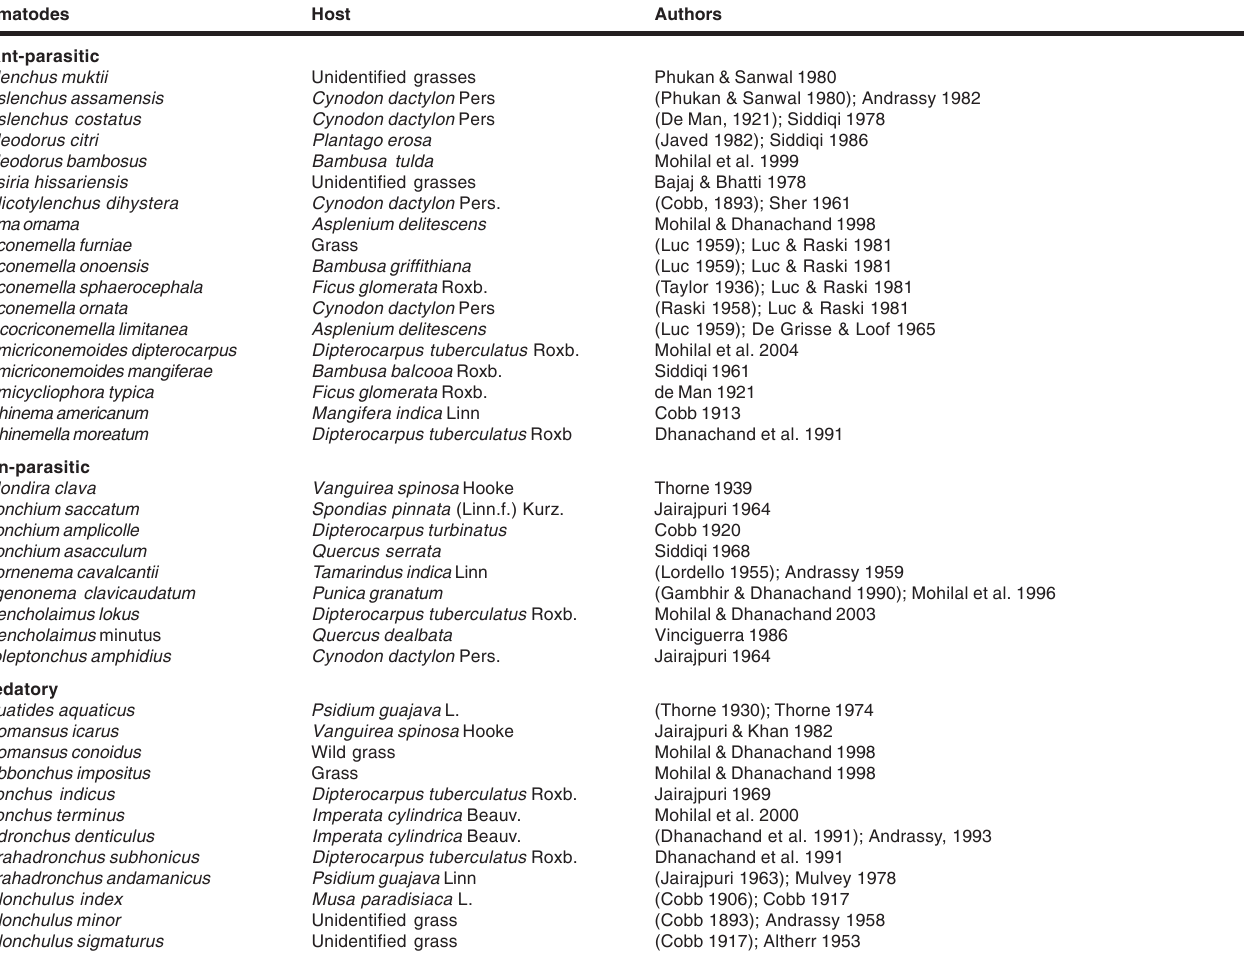
Table 1. List of plant and soil nematode species recorded from Lokchao Yangoupokpi Wildlife Sanctuary